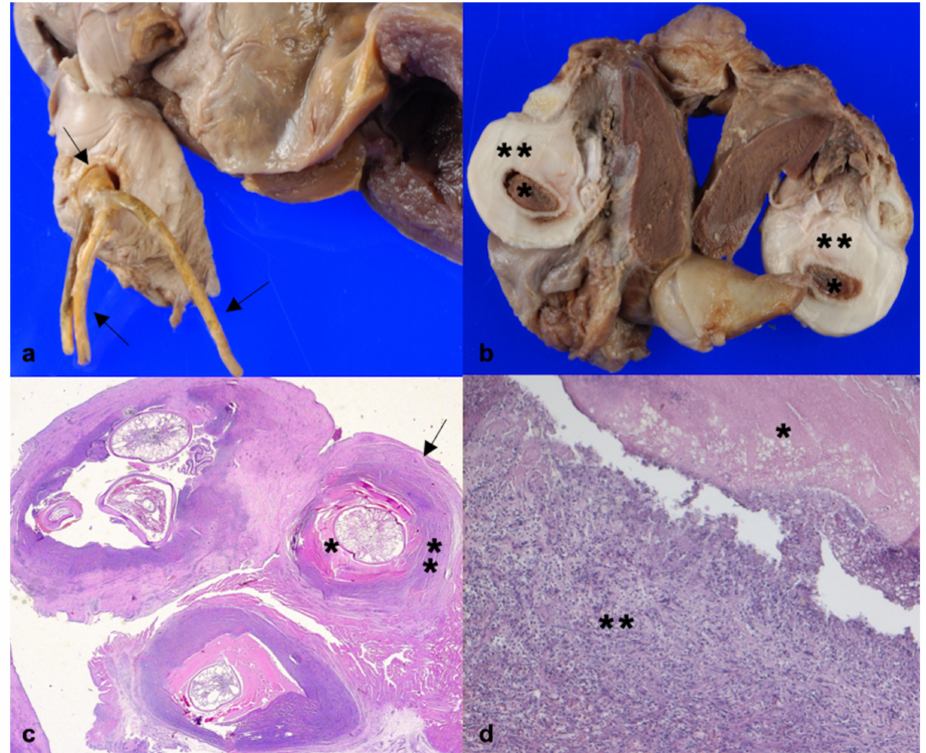
Figure 1. Macroscopic and microscopic features of Pennella infestation in the heart of swordfish ( Xiphias gladius ): ( a ) heart, Pennella sp. (black arrows) in the atrium; ( b ) heart, cutting surface of parasitic nodules showing a necrotic centre (asterisk) and a thick fibrous capsule (double asterisk); ( c ) heart, multiple parasitic nodules showing parasites surrounded by necrosis (asterisk), inflammation (double asterisk), and a fibrous capsule (black arrow), HE, 50x; ( d ) heart, higher magnification of the necrosis (asterisk) and mixed inflammation (double asterisk) in the myocardium surrounding the parasites (HE,